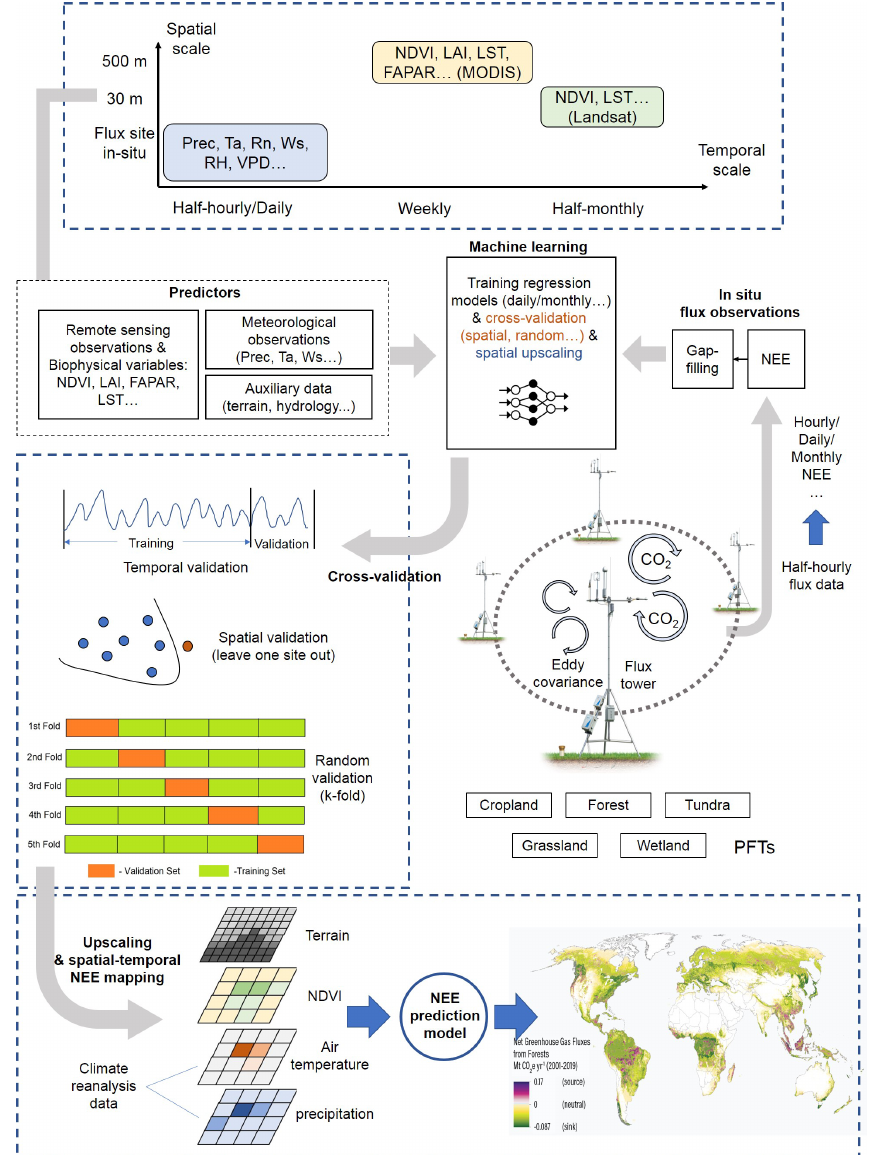
Figure 2. Features of the machine-learning-based NEE prediction process. The flux tower photo is from https://www.licor.com/env/support/ Eddy-Covariance/videos/ec-method-02.html (last access: 23 March 2022). The map in the lower part is from Harris et al. (2021). P , T a , R n , W s , RH, and VPD represent precipitation, air temperature, net surface radiation, wind speed, relative humidity, and vapor-pressure deficit, respectively. FAPAR is the fraction of absorbed photosynthetically active radiation. LST is the land surface temperature. LAI is the leaf area